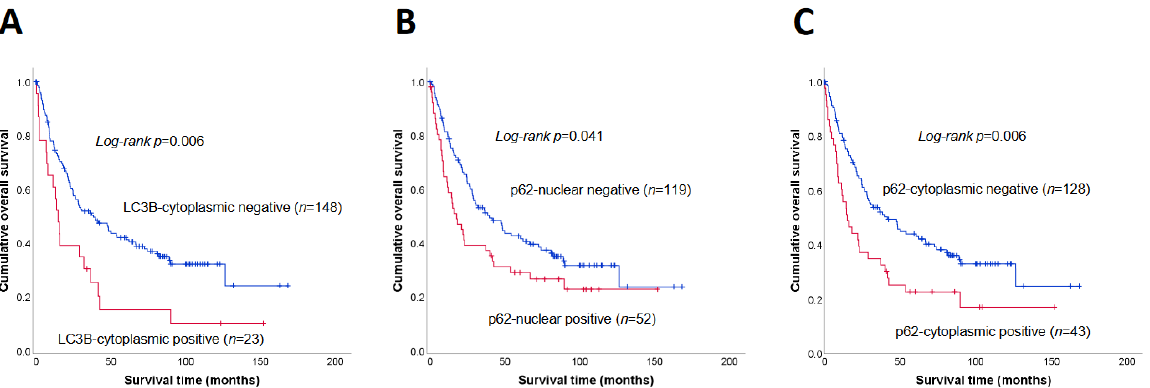
Figure 4. The Kaplan–Meier OS analysis of patients with SIAC. Patients with LC3B+ ( A ), p62 Nu + ( B ), and p62 Cy + ( C ) ex- pression showed poor OS compared to patients with negative expression for each of these proteins (log rank p = 0.006, 0.041, and 0.001, respectively).